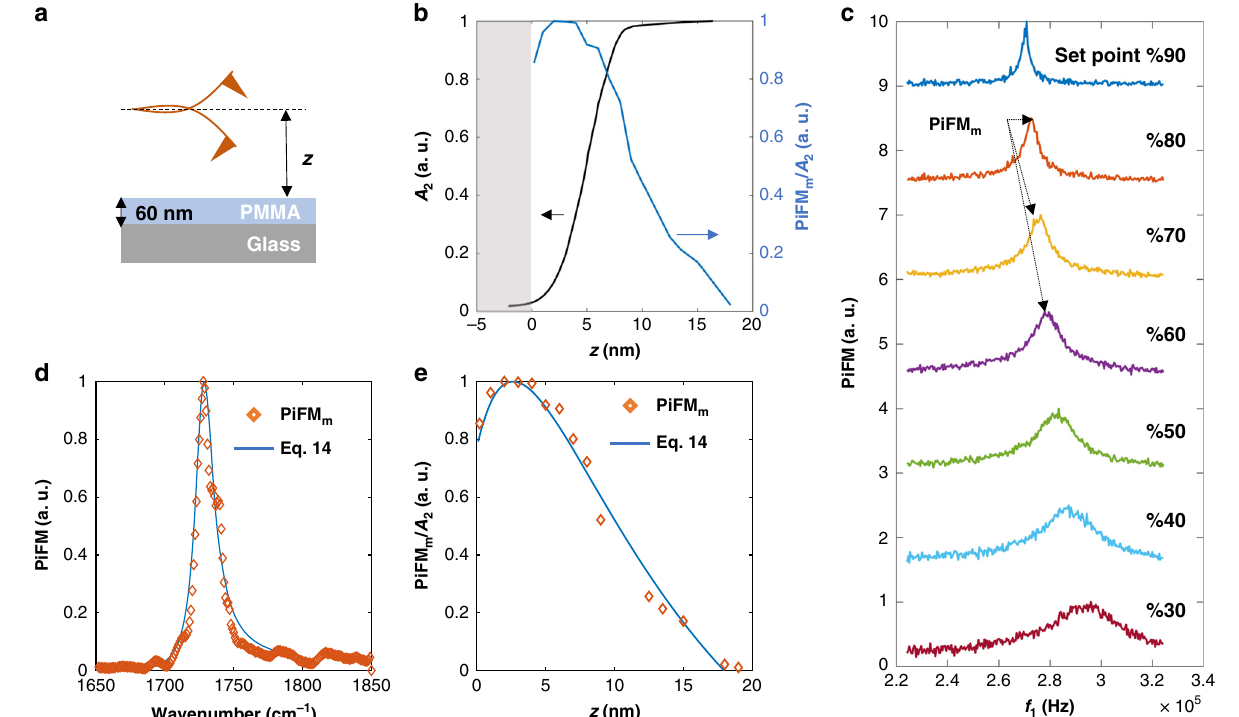
Fig. 6 Experimental and theoretical results of opto-mechanical damping. a Schematic of the tip and sample. b Amplitude A 2 measured at f 2 (black line) and maximum value of PiFM signal (PiFM m ) measured at f 1 (blue line) as a function of average tip – sample distance. The shift in the peak value of f 1 as a function of average tip – sample distance is tracked in c and normalized by the correspondent amplitude measured at f 2 . The set point for each curve in c is indicated as percentage of the amplitude of the cantilever oscillation at f 2 . d , e are comparisons of the experiment (diamond) and Eq. (15) and Eq. 16 (solid line) for point spectrum and approach curve,